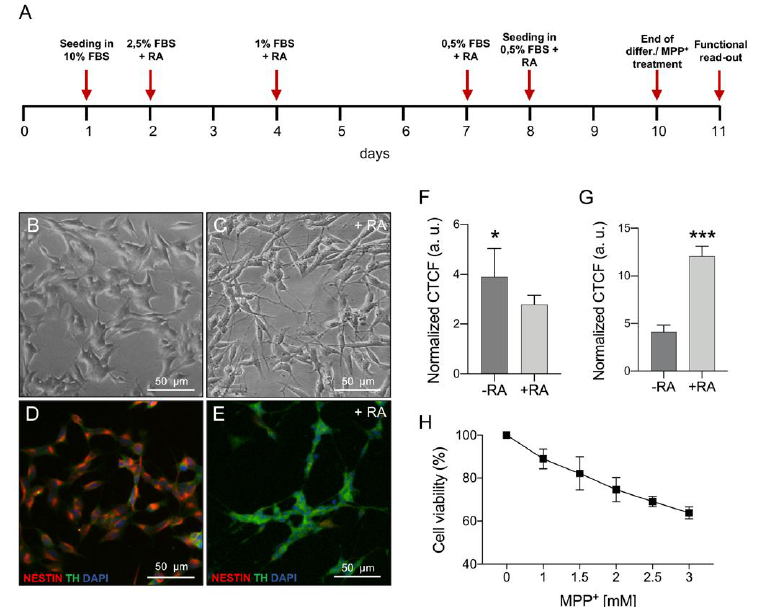
Figure 1. Phenotypic characterization of undifferentiated vs. differentiated SH-SY5Y cells and MPP + dose–response curve. ( A ) Timeline of the differentiation protocol. ( B,C ) Brightfield images showing morphological differences between undifferentiated cells on day zero ( B ) and differentiated cells at day nine ( C ); RA, retinoic acid. ( D,E ) Immunofluorescence images showing the different expression of nestin (red) and TH (green) in undifferentiated ( D ) and differentiated ( E ) cells. ( F,G ) Relative quantification of nestin ( F ) and TH ( G ) in undifferentiated and differentiated cells. ( H ) Dose–response curve for selected MPP + concentrations on differentiated SH-SY5Y cells. * p < 0.05 and *** p < 0.001.